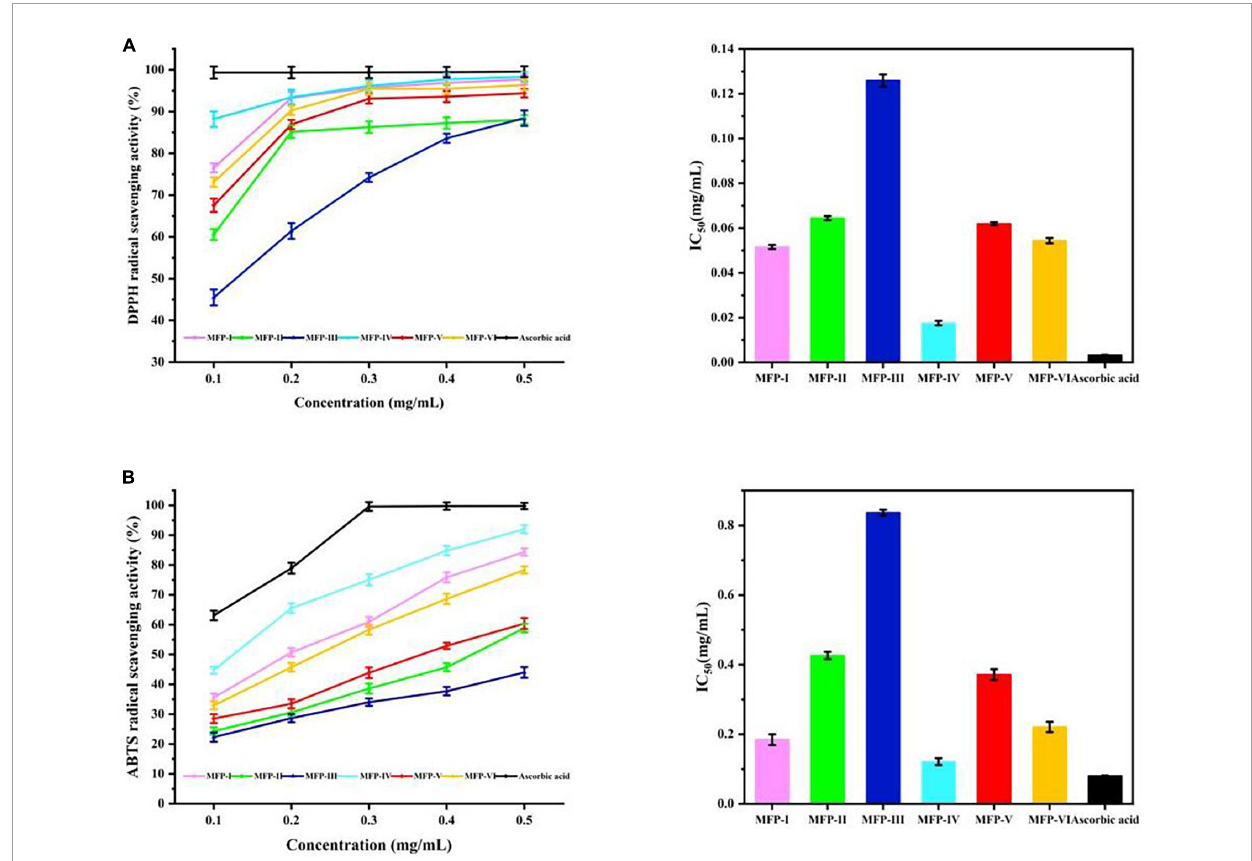
FIGURE9 In vitro antioxidant activity of MFP: (A) DPPH radical scavenging rate; (B) ABTS radical